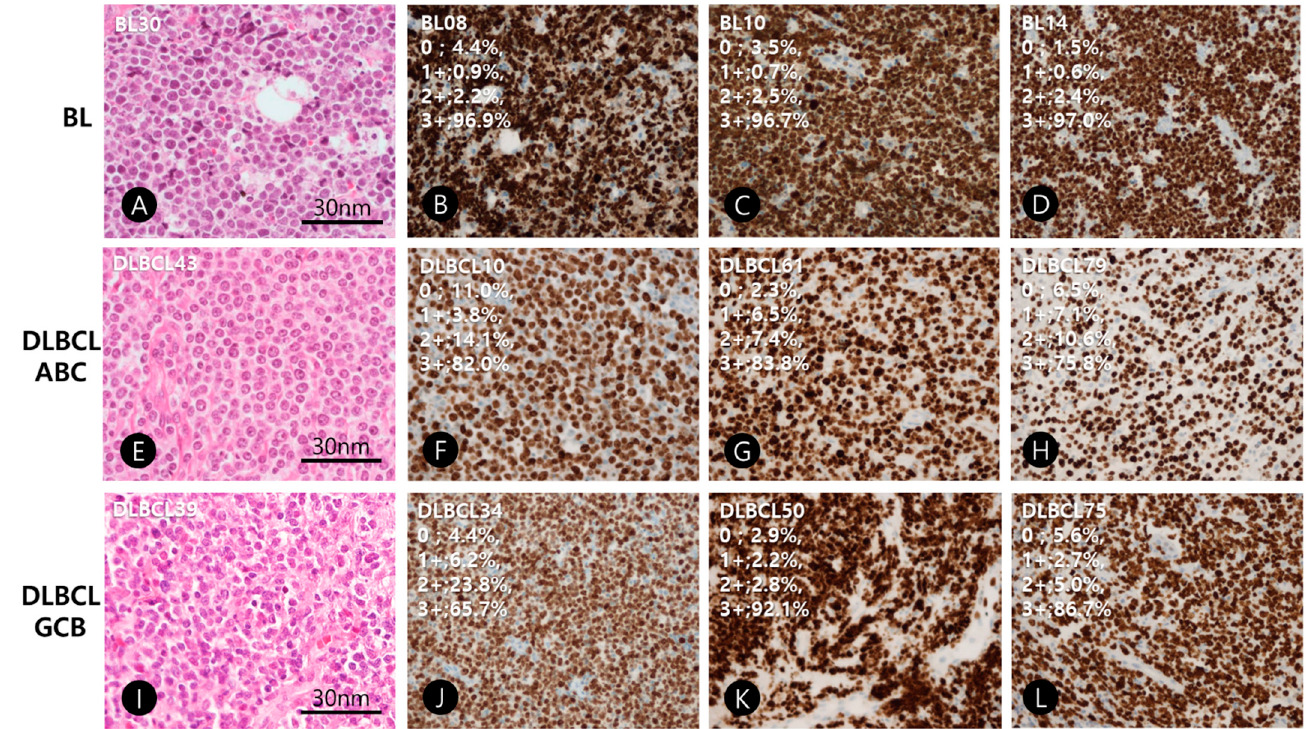
Figure 1. Representative figures of hematoxylin and eosin stains and Ki-67 immunohistochemistry of Burkitt lymphoma (BL), diffuse large B-cell lymphoma, activated B-cell type (DLBCL, ABC) and germinal center cell type (DLBCL, GCB). ( A–D ); BLs (Case No. BL30, BL08, BL10, and BL14), ( E–H ); DLBCL, ABC (Case No. D043, D010, D061, D079), ( I–L ); DLBCL, GCB (Case No. D039, D034, D050, D075).